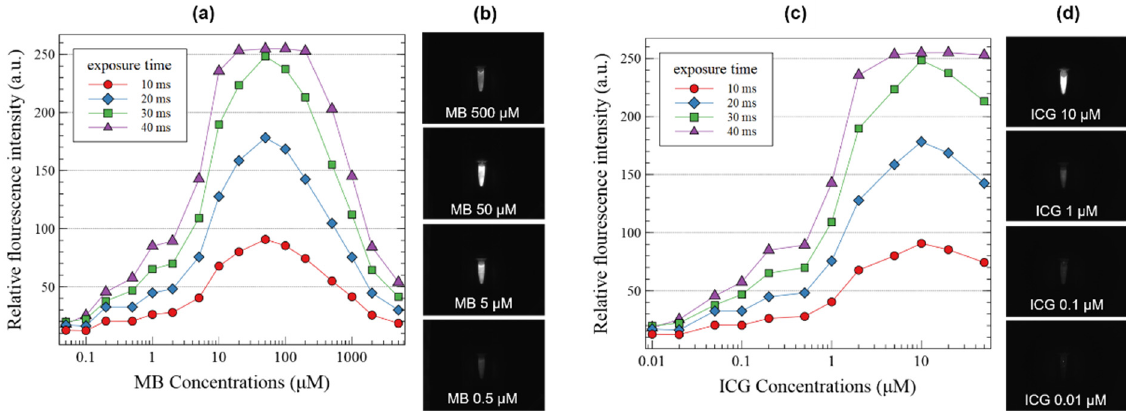
Figure 5. ( a ) Sensitivity of methylene blue (MB) and ( c ) indocyanine green (ICG) depending on the concentrations of the two fluorescent contrast agents and exposure time of the camera. ( b ) NIR images of MB; ( d ) NIR images of ICG.